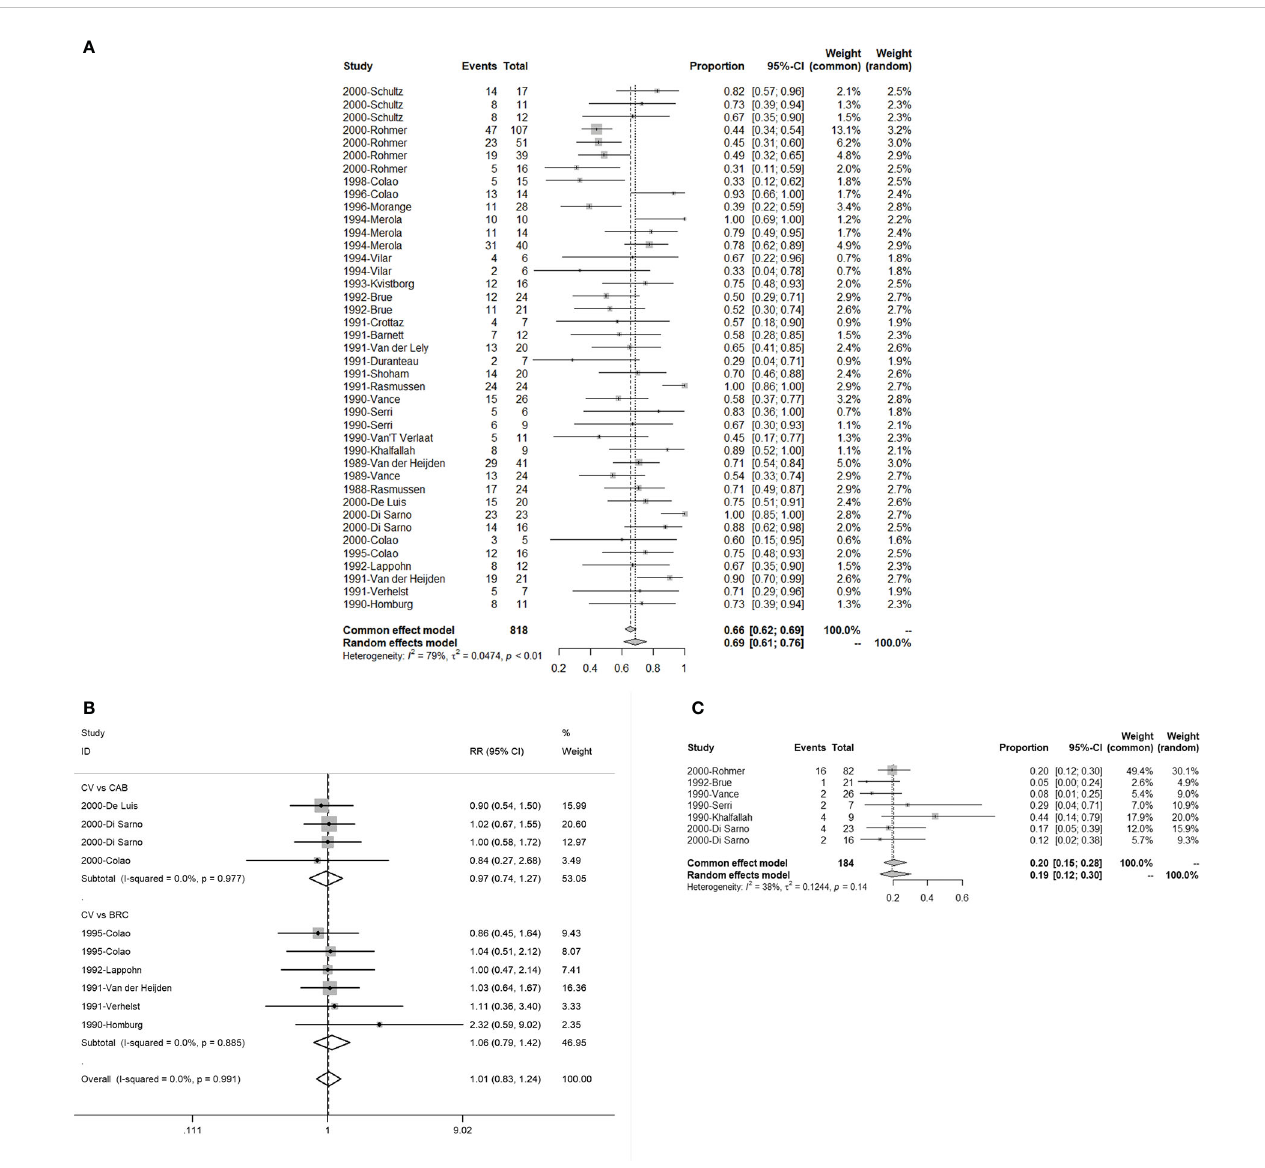
FIGURE 2 The ef fi cacy of quinagolide (CV) in hyperprolactinemia and prolactinoma treatment. (A) The bulk ef fi cacy of CV treatment in hyperprolactinemia; (B) The pooled risk ratios (RRs) of ef fi cacy between CV vs. cabergoline (CAB) and CV vs. bromocriptine (BRC); (C) The ef fi cacy of CV treatment in